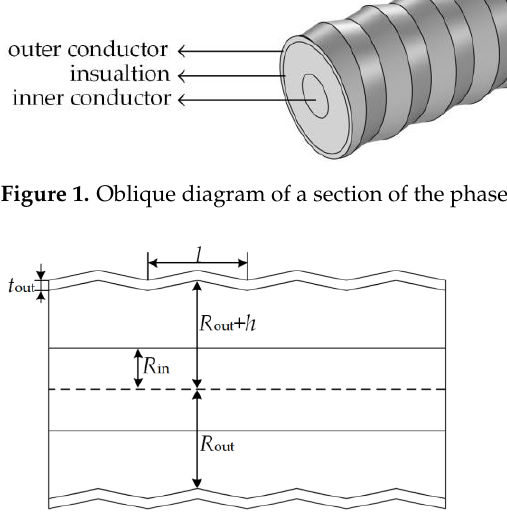
Figure 2. Cross-section view of the corrugated cable in Figure 1. Table 1. Explanation of the notations in Figure 2.